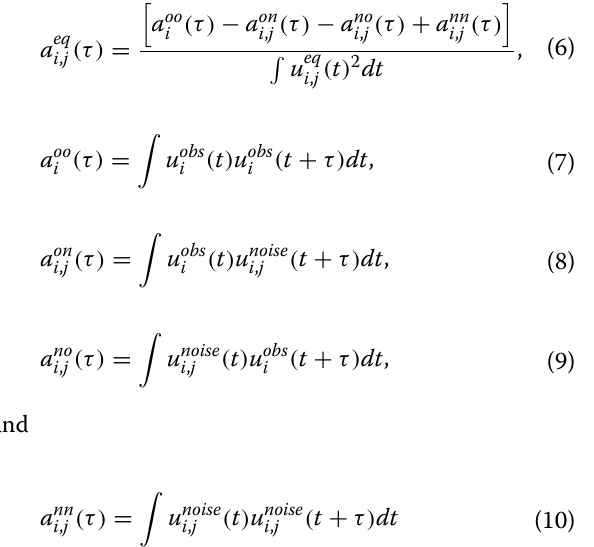
smaller velocity contrasts within the low-velocity